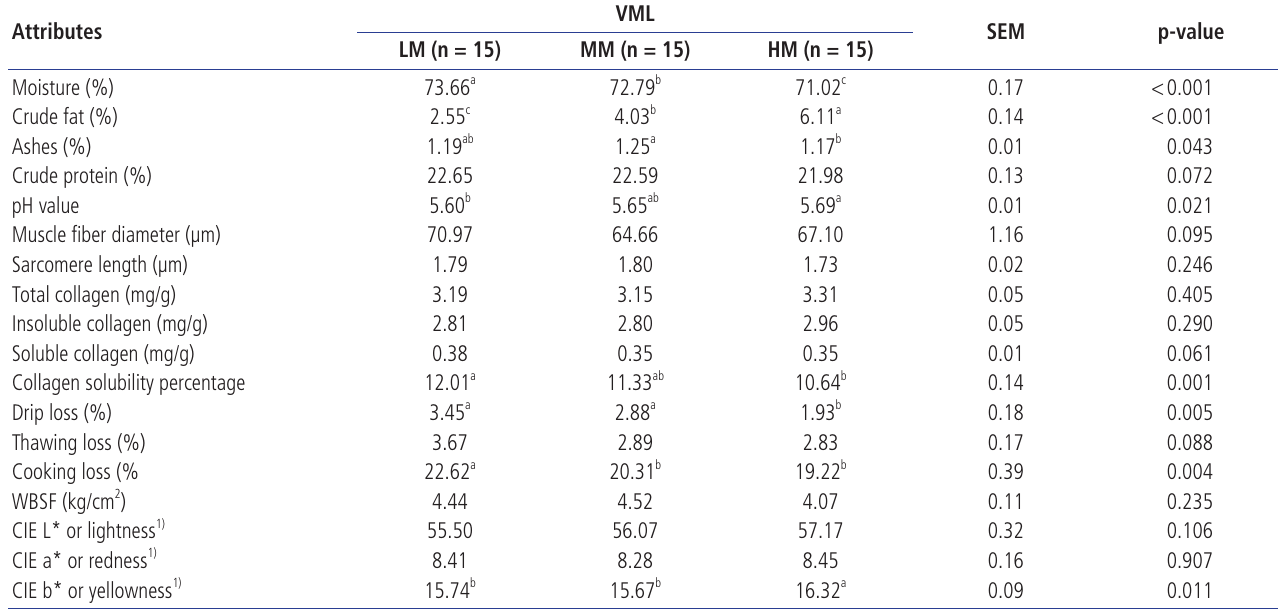
Table 1. Effects of visual marbling level (VML), categorized as low (LM, score 1-2), moderate (MM, score 3-4), and high (HM, score 5-6) according to the US National Pork Board [23] standard, on physicochemical quality traits of pork Longissimus dorsi muscles